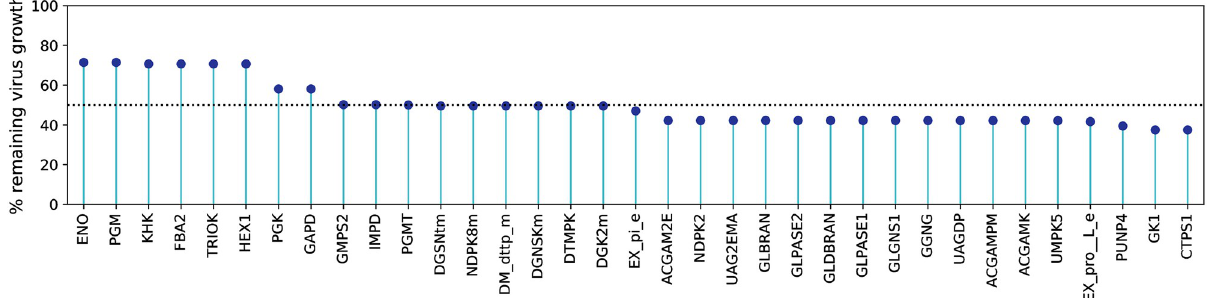
Fig 5. Enzymatic targets of SARS-CoV-2 from the HDE experiments applied to the Recon1-HBEC model. Potential antiviral targets were reported when the virus rate of growth with shifted bounds was beneath the threshold of 90% of its initial growth rate. Enzymes with adapted bounds from the purine and pyrimidine metabolism led to a remarkable virus decrease, while further promising targets were reported from the carbohydrate metabolism. The dashed line represents the 50% of the virus remaining.